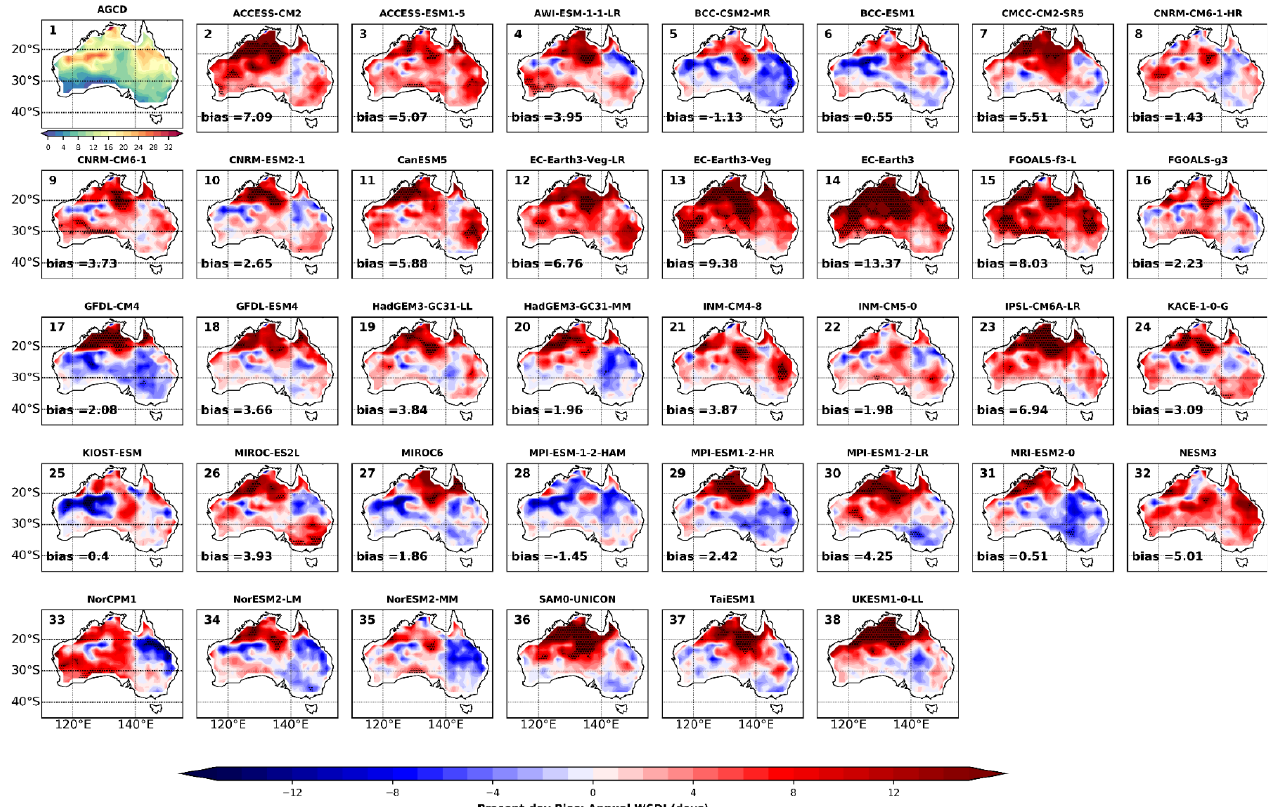
Figure 12. Climatological mean annual bias in the annual count of days with at least 4 consecutive days when daily maximum temperature > 90th percentile (WSDI: days) relative to Australian Gridded Climate Data dataset (AGCD; panel 1), for the individual CMIP6 GCMs (panels 2–38). Data spans 1951–2014. Stippling indicates statistically significant differences using a student’s t-test at the 95% confidence level.